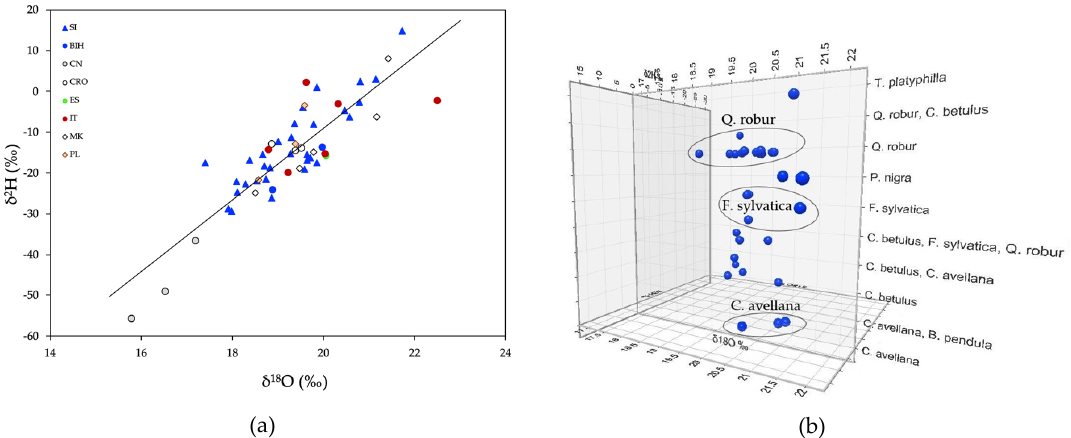
Figure 5. (a ) A plot of the relationship between δ 2 H and δ 18 O of truffle samples from eight countries: SLO (Slovenia), BIH (Bosnia and Herzegovina), CN (China), CRO (Croatia), ES (Spain), IT (Italy), MK (North Macedonia), PL (Poland). A line drawn through the data in the plot shows that the data are strongly linked together (y = 8.1x − 171.8; r 2 = 0.75, p < 0.001); ( b ) comparison of natural isotopic abundance ( δ 2 H and δ 18 O) of T. aestivum in association with host tree species in mixed forest systems (Table S1, Supplementary material).